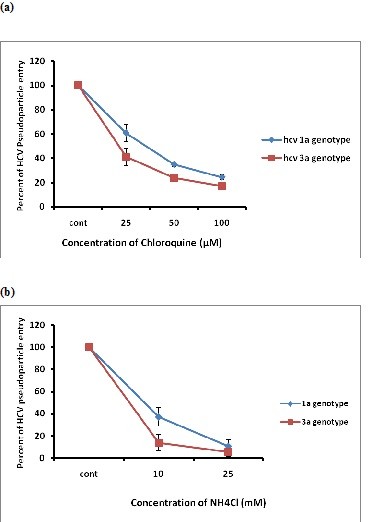
Dose-dependent inhibition of HCVpp of 3a and 1a genotype with lysosomotropic agents. HCVpp were produced in HEK 293 T cells and collected in media after filtration in 0.45 micron filter. Huh-7 cells were incubated in the presence or absence of Lysosomotropic agents such as Chloroquine and NH4Cl at 37°C for 30 min. After 30 min Huh-7 cells were infected with HCVpp of 3a and 1a genotype in the presence or absence of different concentrations of lysosomotropic agents and incubated for additional 24 h. After 24 h cells were lysed and luciferase activity was determined by using a luminometer. Luciferase activity is not reported as an absolute value, but is calculated relative to the 'no drug' condition and reported on the y-axis as a percentage. Results are represented as the average and standard error for three independent experiments. (a) Dose-dependent inhibition of Chloroquine against HCVpp of 1a and 3a genotype. (b) Dose-dependent inhibition of NH4Cl against HCVpp of 1a and 3a genotype. P value > 0.05 vs control was considered as statistically significant.